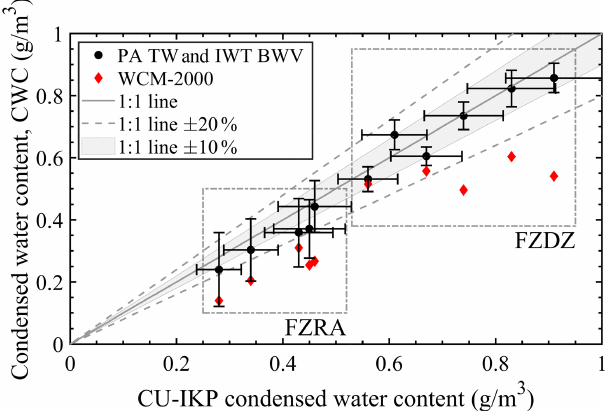
Figure 14. Mean measured CWC of the PA system in combina- tion with the IWT background humidity measurement and of the hot-wire probe (WCM-2000) over the CWC measured by the Cran- field University IKP (CU-IKP). Dash-dotted rectangular boxes in the figure mark measurements of freezing rain (FZRA) and freez- ing drizzle (FZDZ) with MVDs of approximately 550µm to 650µm and 100µm, respectively. Vertical error bars mark the standard devi- ations of the measurements. Horizontal error bars indicate the IWT cloud LWC uniformity ( ± 15% and ± 10% for freezing drizzle and freezing rain,